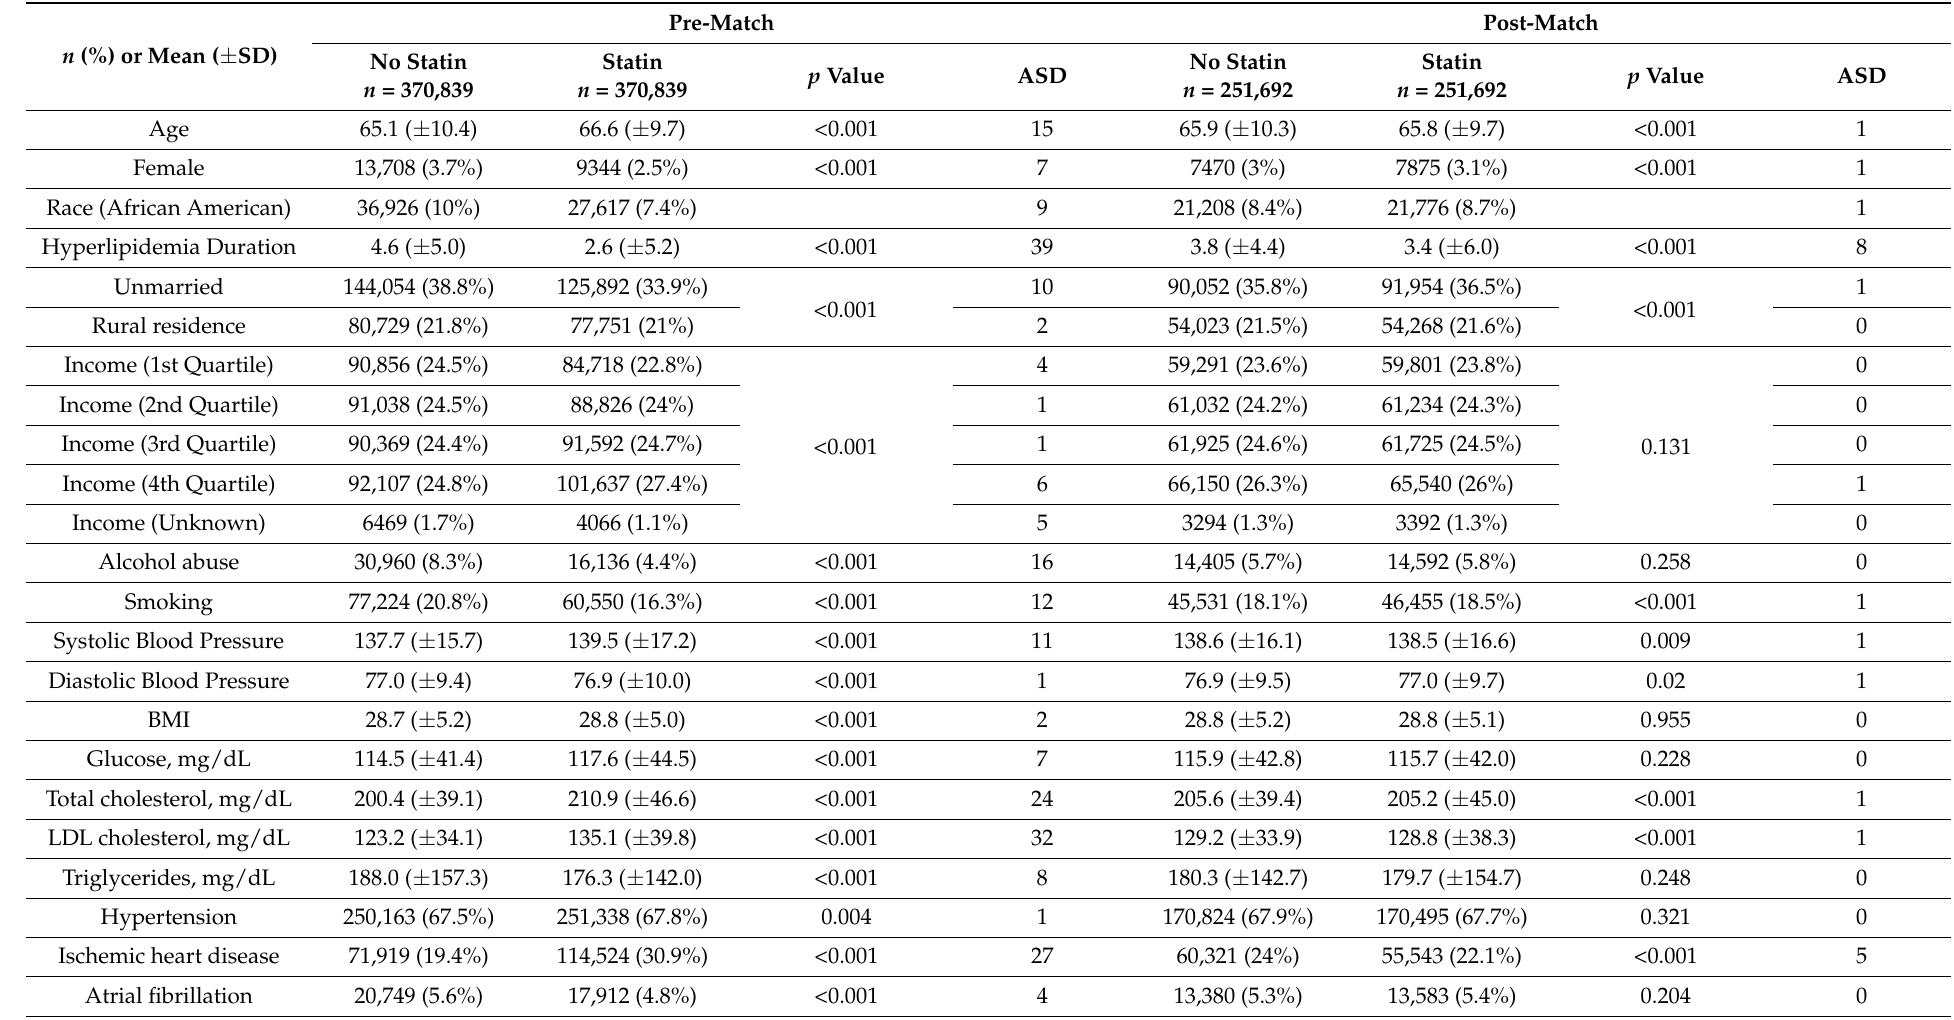
Table 2. Demographic and clinical characteristics of the statin user